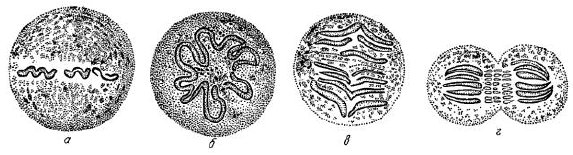
Figure 1. Drawing of dividing nuclei by Schneider, 1873 [1].